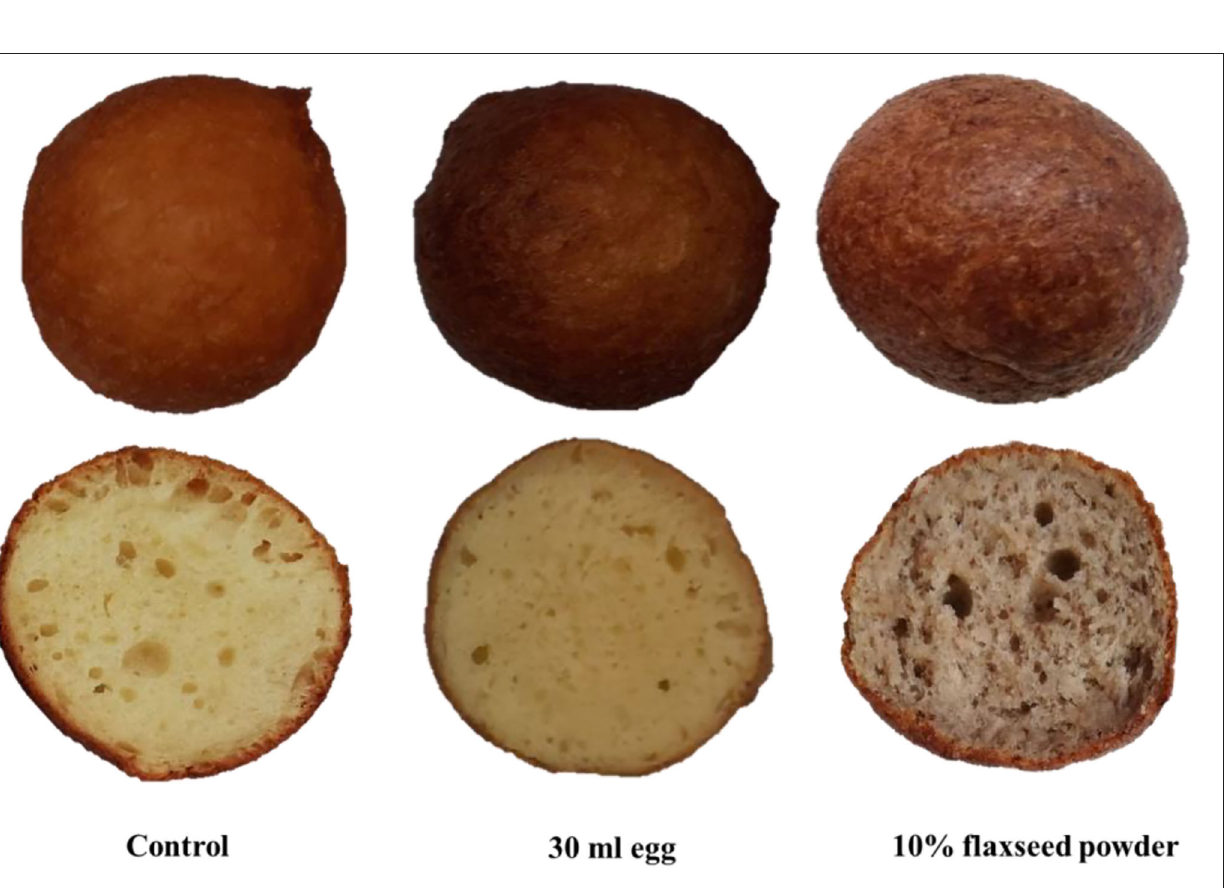
FIGURE 2 | Fried cereal-dough